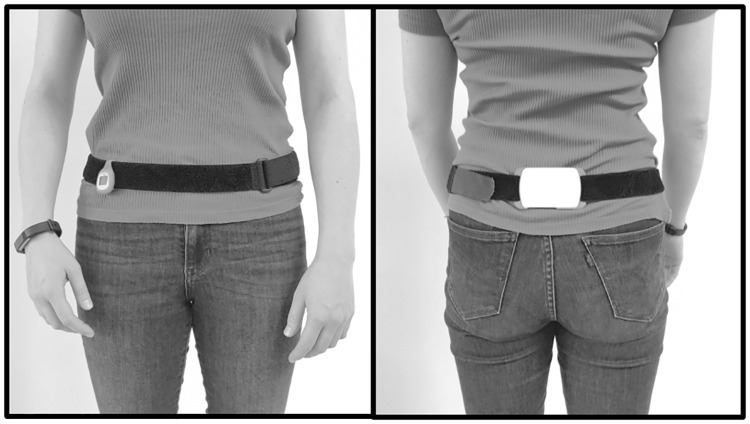
Positioning of the Fitbit Zip (hip), Fitbit Alta (wrist) and Dynaport Movemonitor (lower back).